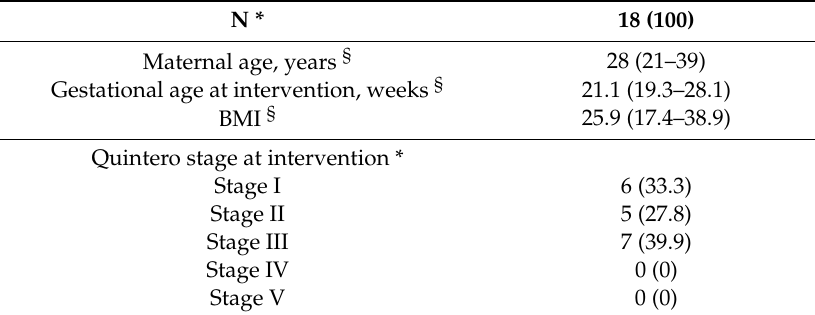
Table 1. Patient characteristics and Quintero stage at